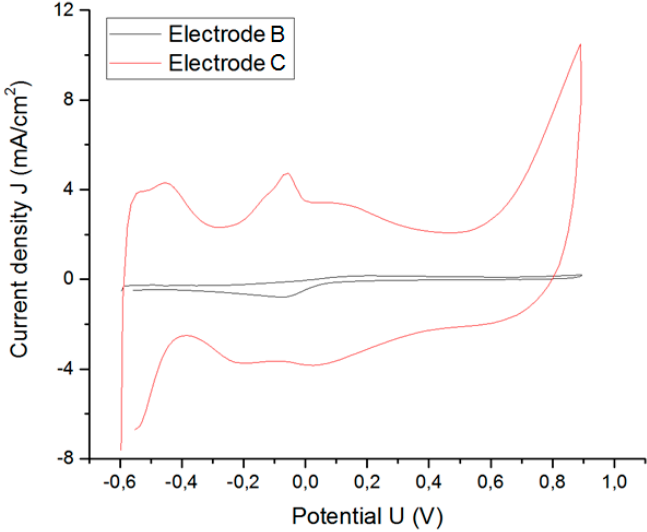
Figure 16. Increase in CSC c due to increase in surface roughness.